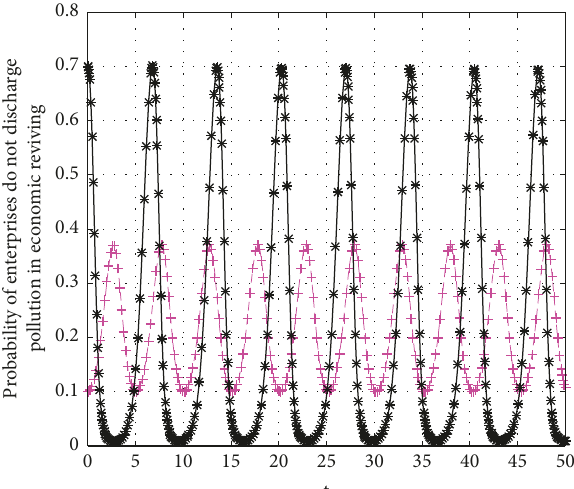
Figure 4: The evolution path of nondischarge in the process of enterprises economic revitalization under the static incentives mechanism and penalties mechanism.